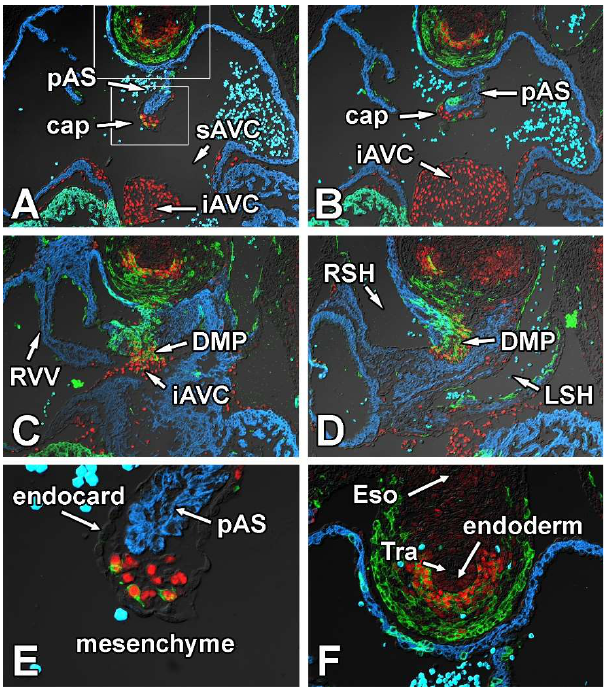
Figure 4. Sox9 expression at embryonic day 11.5. Panels ( A – F ) show the expression of Sox9 (red), Myosin Heavy Chain (blue), and GFP (green) in SHFcre;R26mG embryos at ED11.5. The GFP staining delineates the SHF and SHF-derived cells. Panels ( E , F ) are enlargements of the boxed areas in Panel ( A ). Note the GFP expressing mesenchymal cells within the cap ( A , E ). AVC = atrioventricular cushion, cap = mesenchymal cap, DMP = dorsal mesenchymal protrusion, endocard = endocardium, eso = esophagus, iAVC = inferior AV cushion, LA = left atrium, LSH = left sinushorn, pAS = primary atrial septum, RA = right atrium, RSH = right sinushorn, RVV = right venous valve, sAVC = superior AV cushion, Tra =